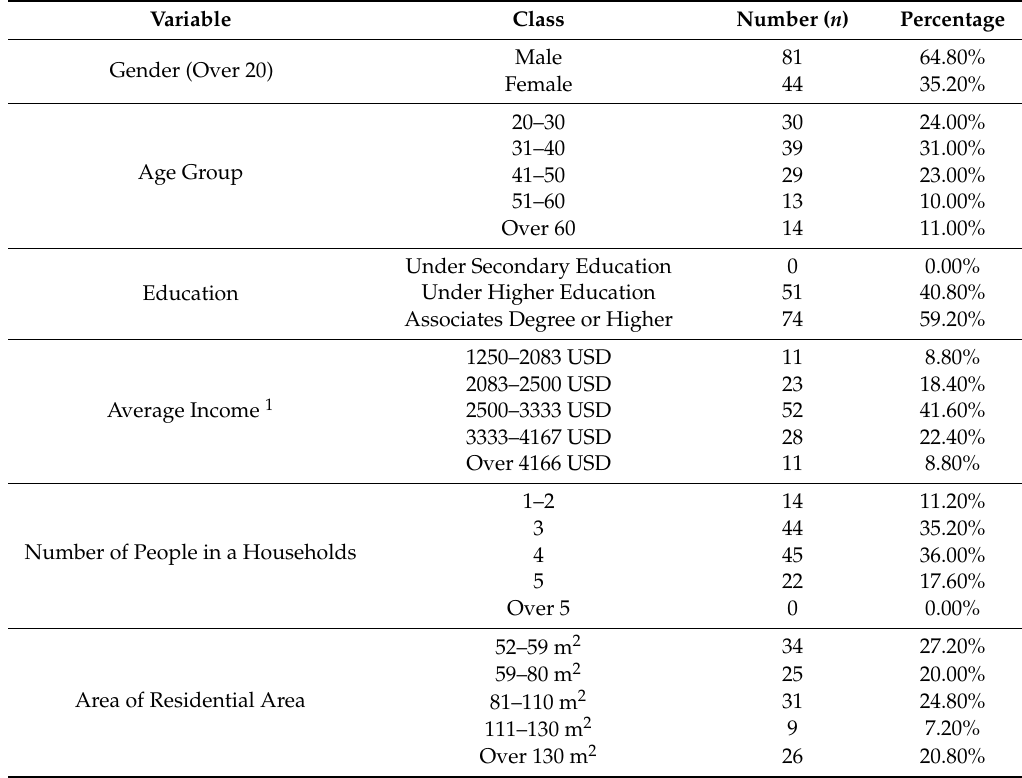
Table 3. Result of General Characteristics of Respondents ( n = 125).